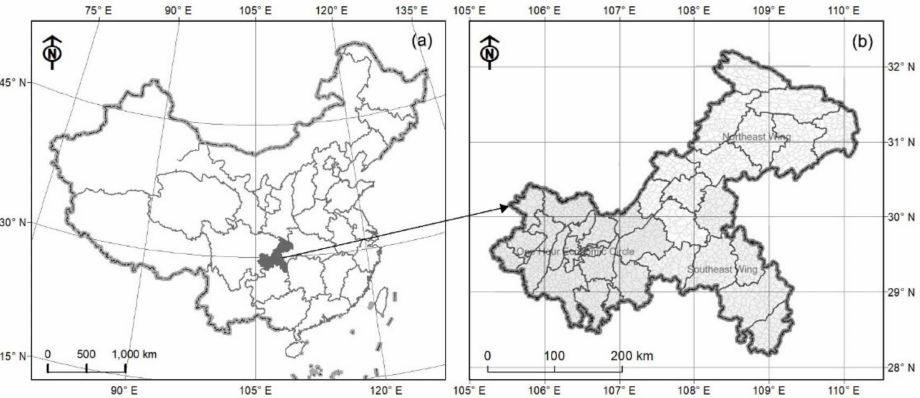
Figure 1. ( a ) Location of Chongqing in China; ( b ) Chongqing metropolis and its spatial